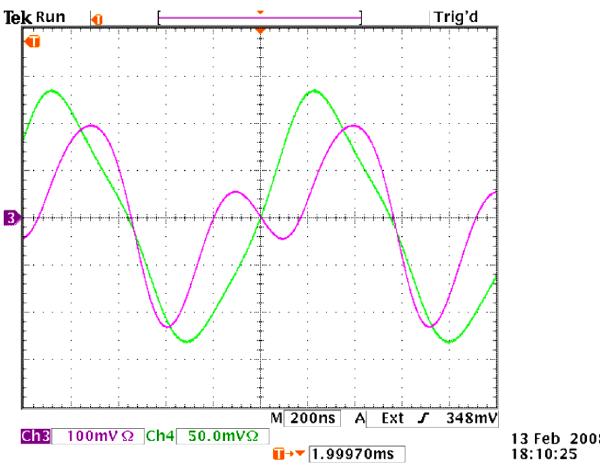
Superposed rf signal (channel 3) and single harmonic waveform (channel 4).